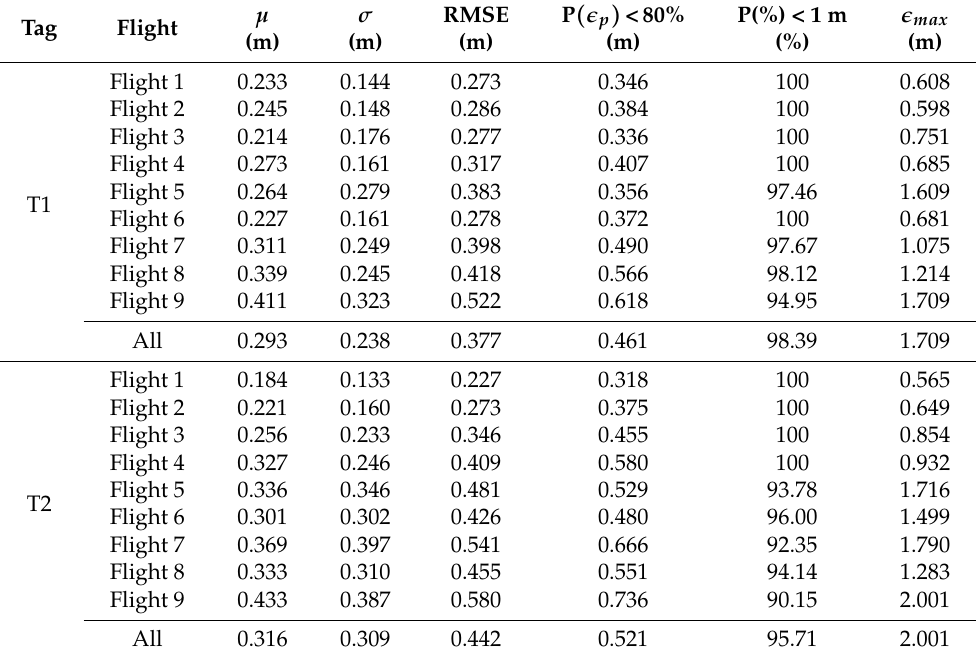
Table 5. Accuracy using only UWB data with four